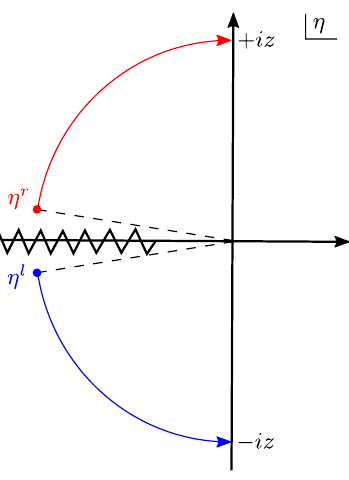
Figure 4 . “Wick rotation” from dS to EAdS, in Poincaré coordinates. The branch-cut for real negative values of η denotes the light-cone singularity and the associated discontinuity for time- like interval. The r/l i(cid:15) prescriptions are illustrated with a displacement of the η variable in the positive/negative imaginary direction. To connect to EAdS, we rotate the variable η all the way to the imaginary axis avoiding the singularity on the real negative axis, i.e. clockwise for η r and anti- clockwise for η l . This implies the identifications (3.15)–(3.17) between the dS and EAdS two-point